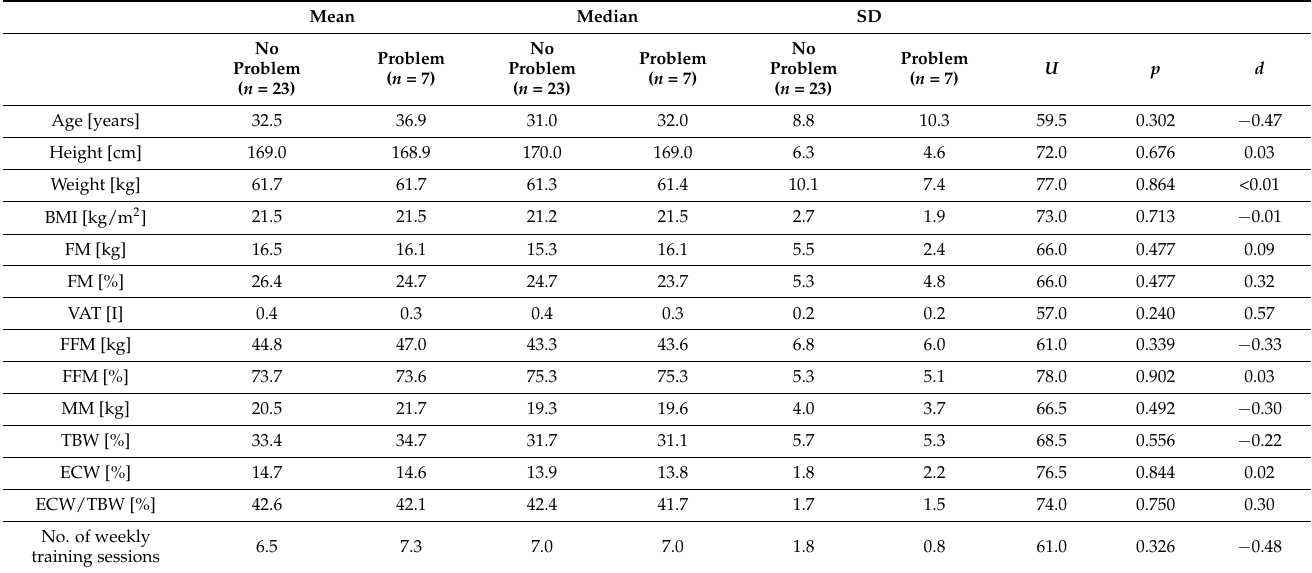
Table 1. Anthropometric and body composition data categorized by menstrual